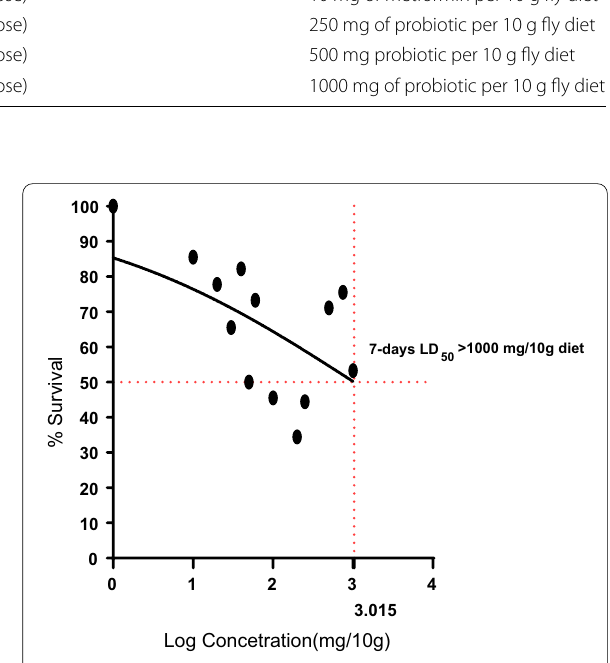
Fig. 1 Lethal concentration of multi-strain probiotic (protexin) after administration in two phases (lesser dose and higher dose) for a period of 7 days